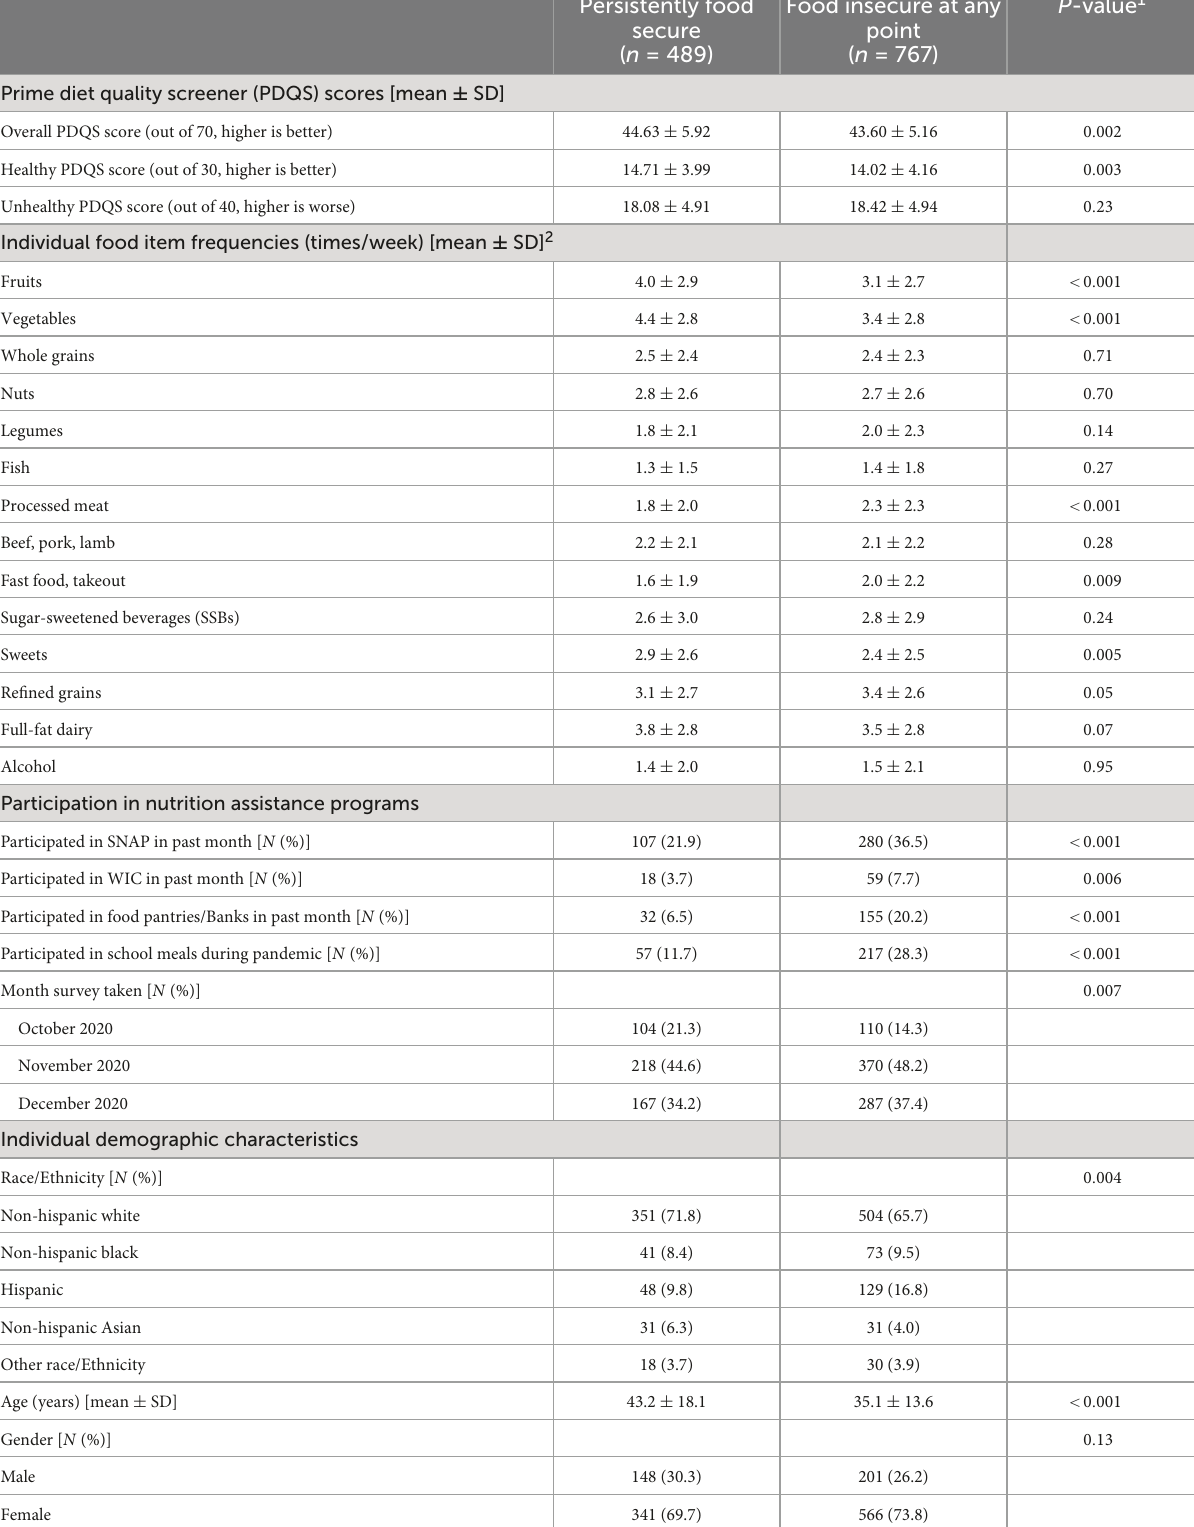
TABLE 1 Sociodemographic and dietary characteristics of Massachusetts adults with household incomes < 300% of the federal poverty line in the MA statewide food access survey, Oct 2020 – Dec 2020 ( n = 1,256).